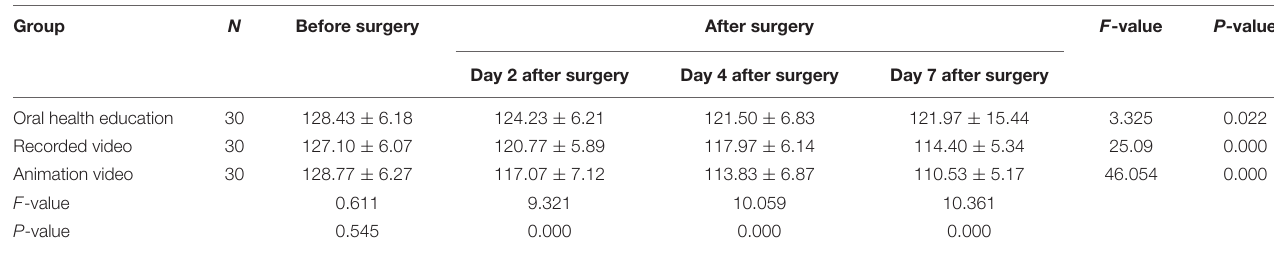
TABLE 5 | Anxiety levels in the three groups.